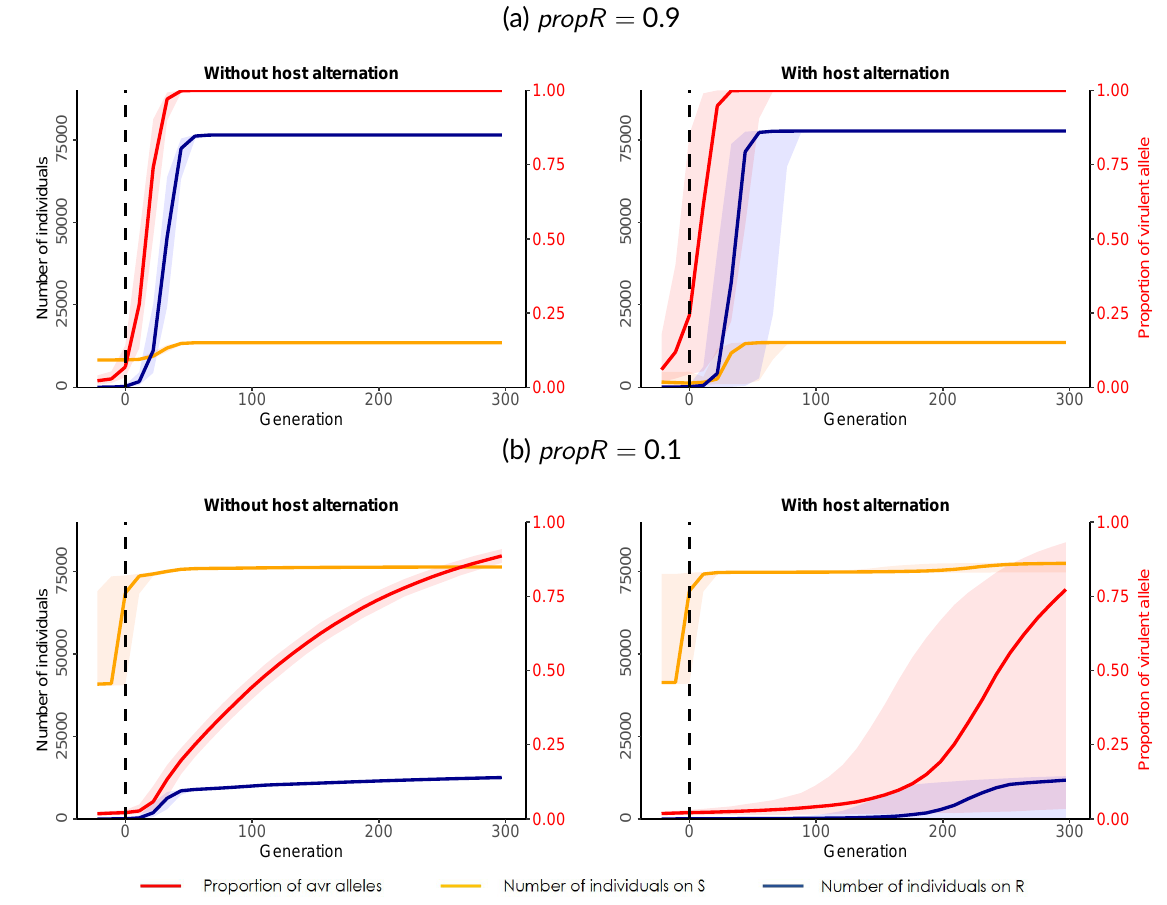
Figure 7 – For diploid pathogens, evolution of the population size in the R and S com- partments (on the left scale) and of the frequency or avr alleles in the S compartment (on the right scale) through generations. Simulations were performed without and with host alternation, for two values of propR : (a) 0.1 and (b) 0.9, with f avr = 0.02 , mig = 0.05 , and r = 1.5 . For each simulation, generation 0 corresponds to the generation at which the invasion occurred. For each combination of parameters, simulations were performed on 1 000 replicates. The plotted results correspond to the median results (frequency of avr alleles or population size) for all simulations among the 1 000 replicates for which we observed a fixation of the avr allele in the population. Coloured intervals correspond to the 95% confidence